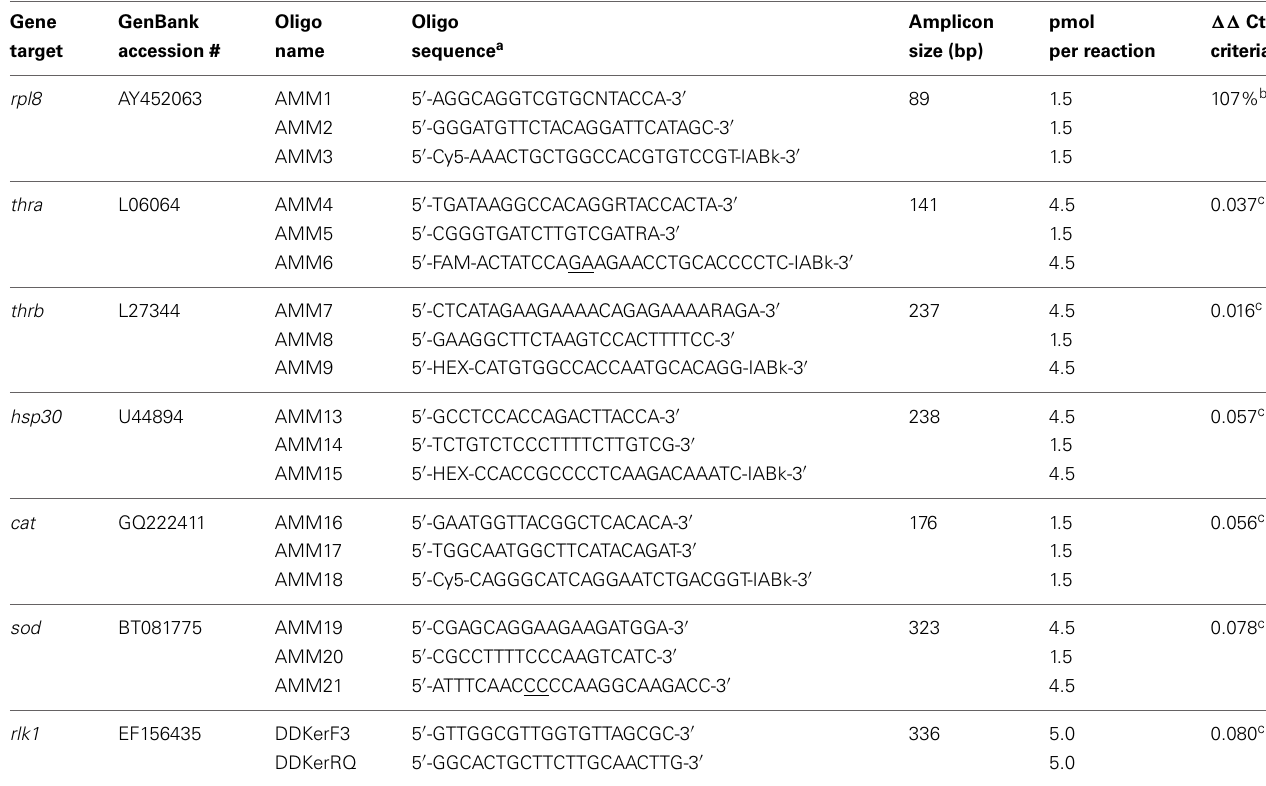
Table 2 | Gene-specific DNA primers and hydrolysis probes for